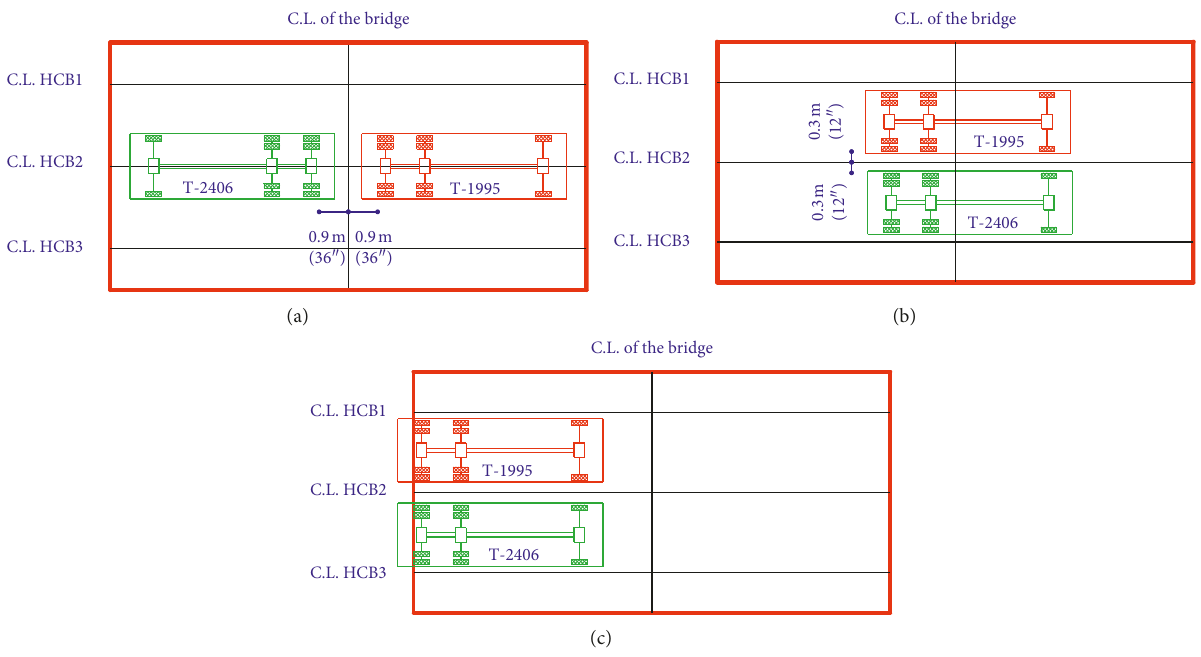
Figure 3: Load testing truck stops. (a) stop 1. (b) stop 2. (c) stop